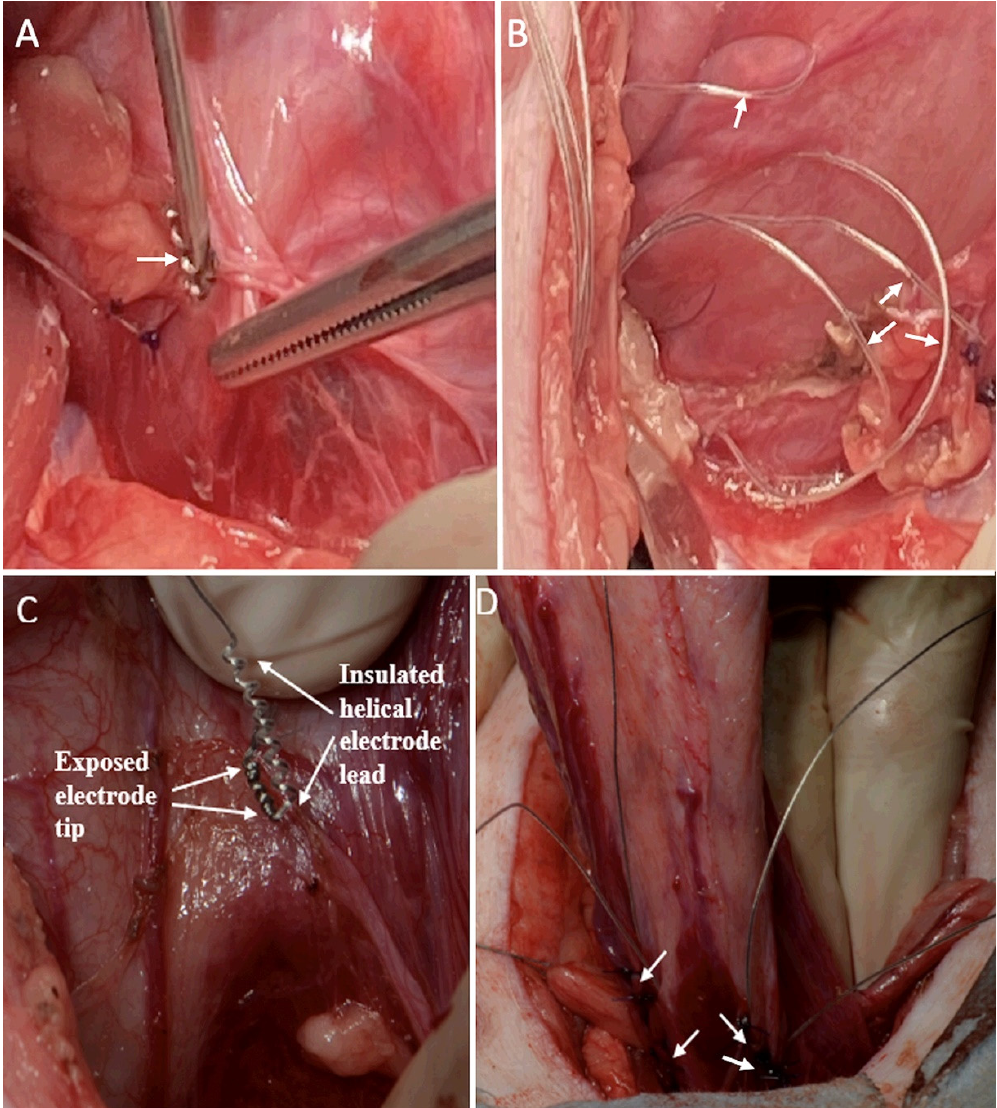
Figure 3. Helical-wire hook electrode implantation in the first minipig with a needle and sutures, and in the second and third minipigs with imbrication and sutures. ( A ) In the first minipig, one electrode is shown after implantation with sutures in place and a second electrode is being implanted with a needle in a more medial–dorsal location (white arrow). ( B ) Looping of four electrode leads for strain relief is shown in the abdominal cavity. ( C ) The imbrication method of electrode implantation is shown for the last two animals. The electrode is over the bladder wall prior to implantation. ( D ) The area of the bladder wall ventral to the trigone is implanted with the four imbricated electrodes (white arrows).